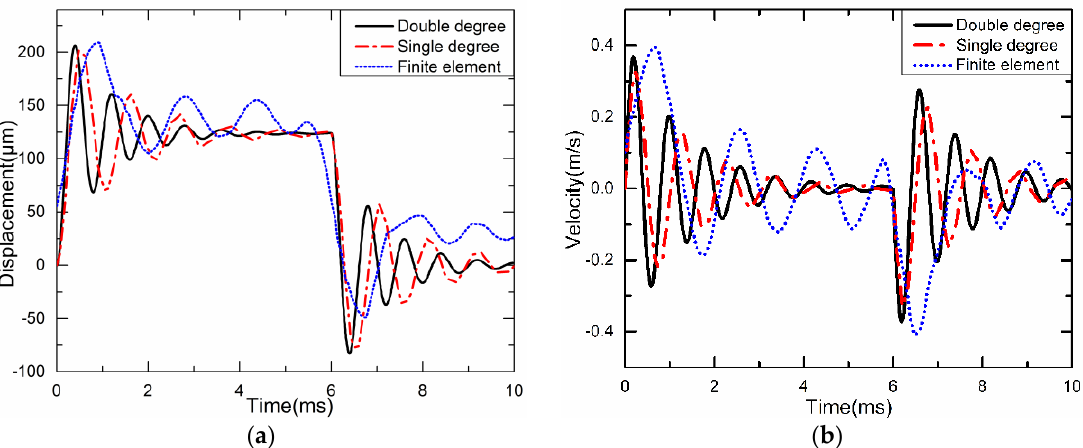
Figure 14. Dynamic characteristics of the needle: ( a ) The vertical displacement graph; ( b ) The vertical